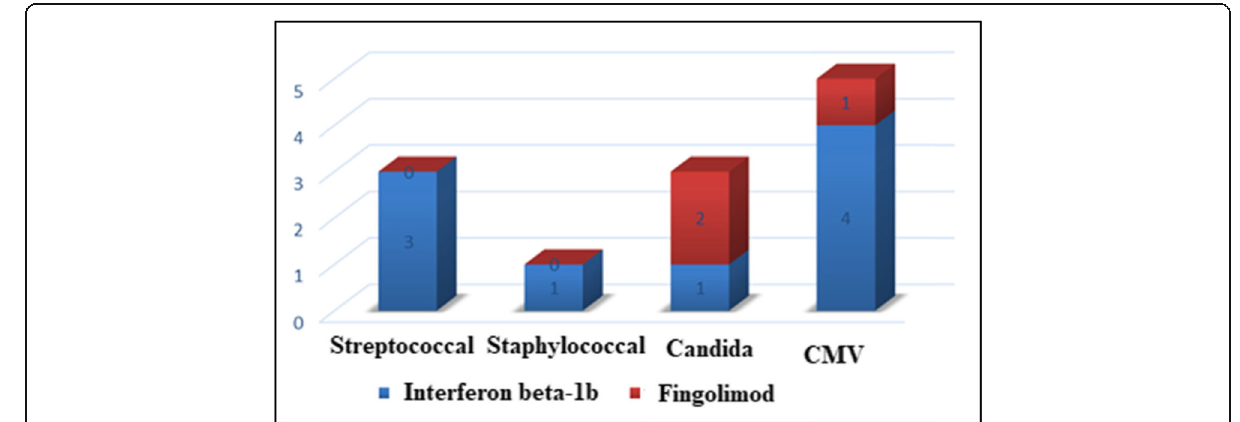
Fig. 2 The prevalence of microorganisms in infective